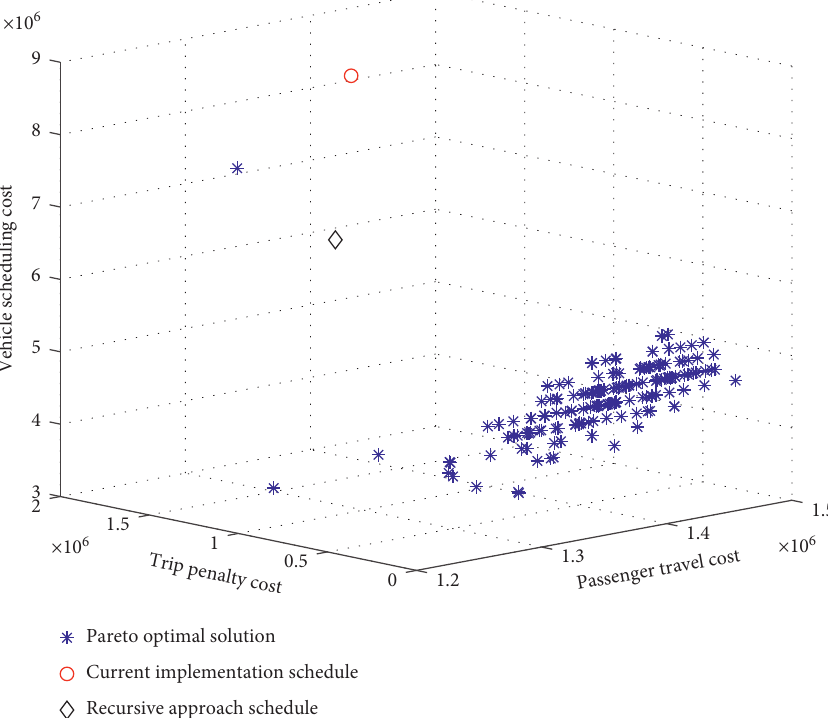
Figure 16: Solution costs of different